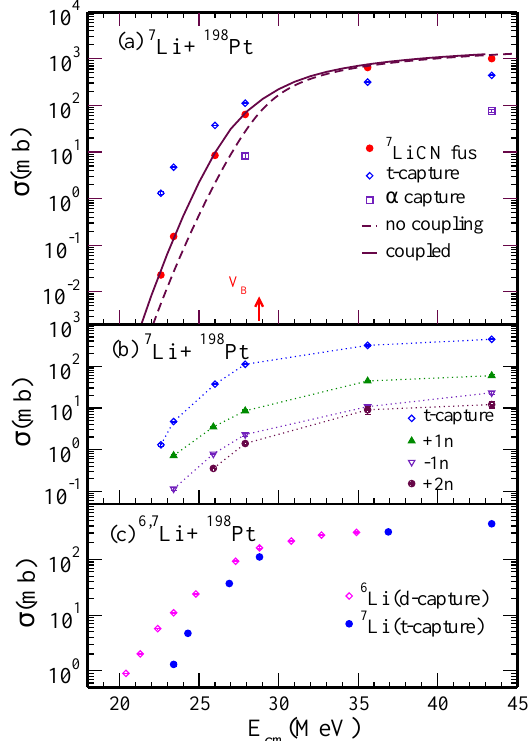
Fig. 3. (color on line) (a) Cross-sections for compound-nuclear fusion and t -capture ( 198 − 200 Au) for 7 Li + 198 Pt. The arrow in- dicates value of the Coulomb barrier (V B ). The results of the coupled-channels calculations (solid line) along with single chan- nel calculations (dashed line) are shown. (b) Comparison of cross-sections from t -capture( 198 − 200 Au) , 1n-pickup ( 197 Pt) and 1n,2n-stripping ( 199 , 200 Pt) reactions. (c) Comparison of d-capture and t-capture processes with 6 Li and 7 Li projectile on 198 Pt. The dashed lines in panels (b) and (c) are to guide the